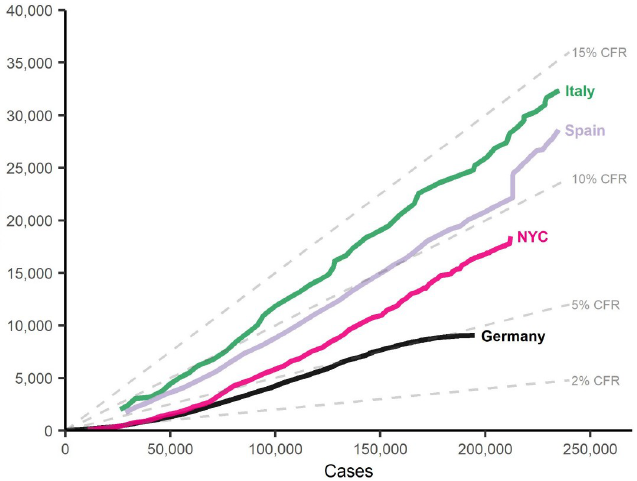
Fig 1. COVID-19 confirmed cases and deaths, and implied case-fatality rates (CFR) in Italy (since March 9, 2020), Germany (since March 1, 2020), Spain (since March 21, 2020), and New York City (since March 22,